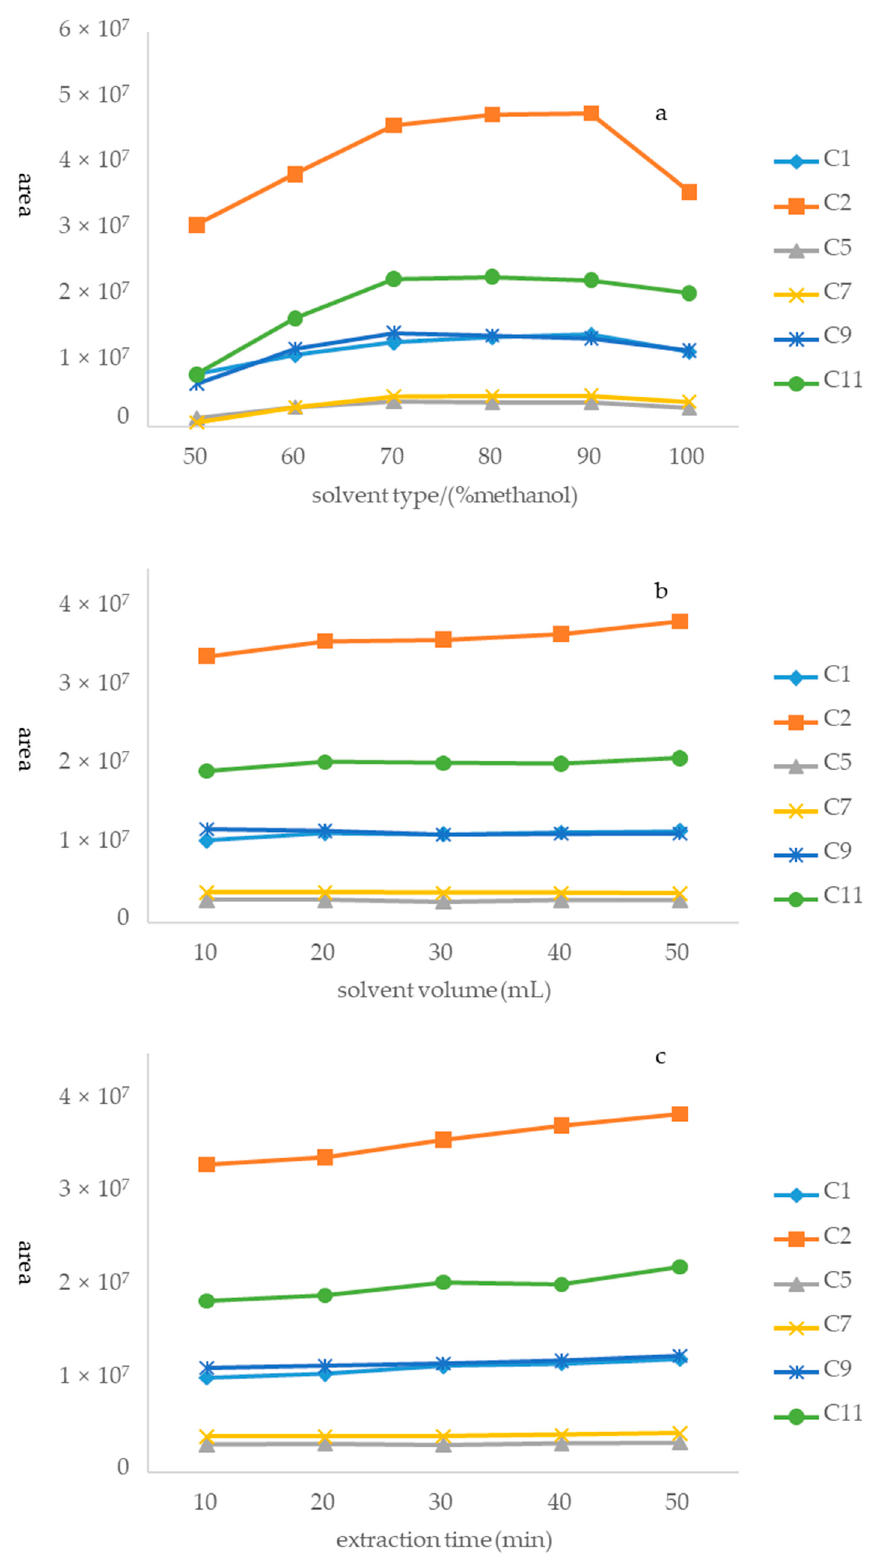
Figure 4. Optimization of different parameters of the method of sample solution: ( a ) type of extractant, ( b ) volume of extractant, and ( c ) ultrasound time.